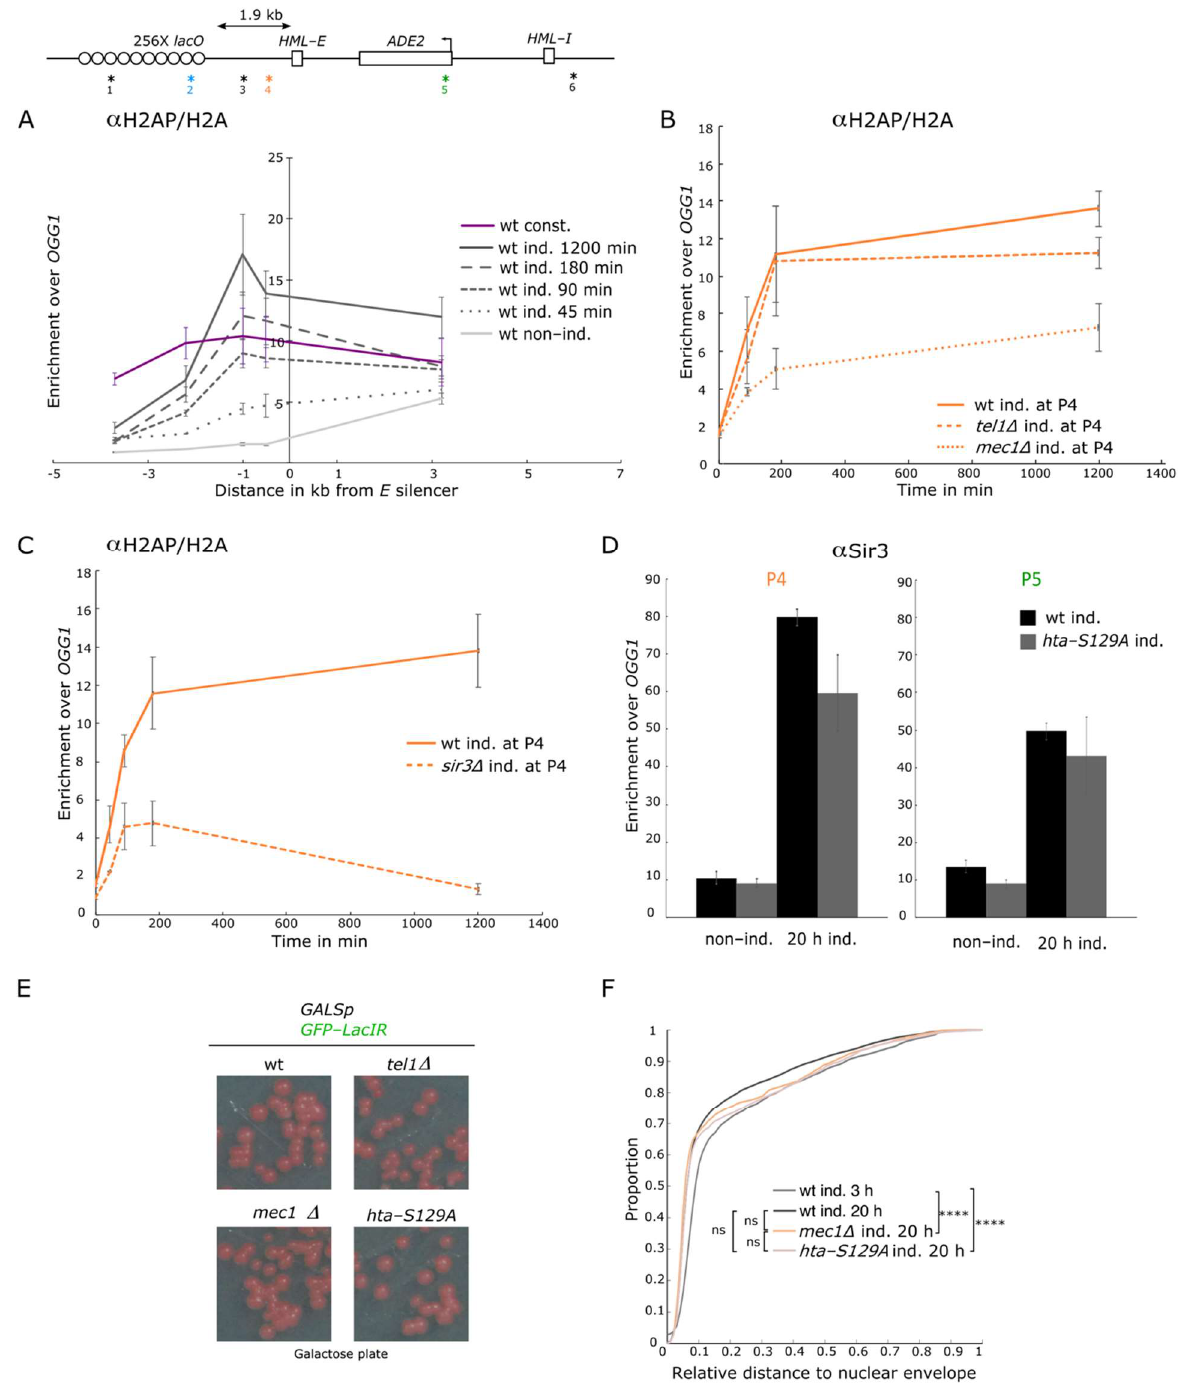
Figure 5. Mec1-dependent H2A phosphorylation induced by LacI binding and stabilized by Sir3 spreading. ( A ) H2A-S129 phosphorylation occupancy along the lys2::lacO E-ADE2-I locus probed by ChIP-qPCR using an anti-H2A Phospho-S129 antibody in strains expressing GFP-LacIR either under the constitutive HIS3 promoter (wt const. yAT2059) or under the inducible GALS promoter (wt ind. yAT2078) in raffinose (no induction), or after 45 min, 90 min, 180 min, and 1200 min of galactose induction. The data were normalized over OGG1 and histone H2A ChIP signal (shown as mean ± s.e.m.; see Table S3 for the number of experiments). (P1), (P2), (P3) (P4) amplicons are respectively located at 3.7 kb, 2.2 kb, 1 kb, and 0.5 kb from the left side of the E silencer, and (P5) and (P6) amplicons are located at 3.2 kb and 6 kb from the right side of the E silencer,amplicon positions are localized with an asterisk and their respective number on the scheme of the locus . ( B ) H2A-S129 phosphorylation enrichment over time nearby the E silencer (P4) in strains bearing the lys2::lacO E-ADE2-I locus , probed by ChIP-qPCR using an anti-H2A Phospho-S129 antibody, in strains expressing GFP-LacIR under GALS promoter in the WT (wt ind., yAT2078), in a tel1∆ ( tel1∆ ind,. yAT2314), and in a mec1∆ ( mec1∆ ind., yAT2904) strains in